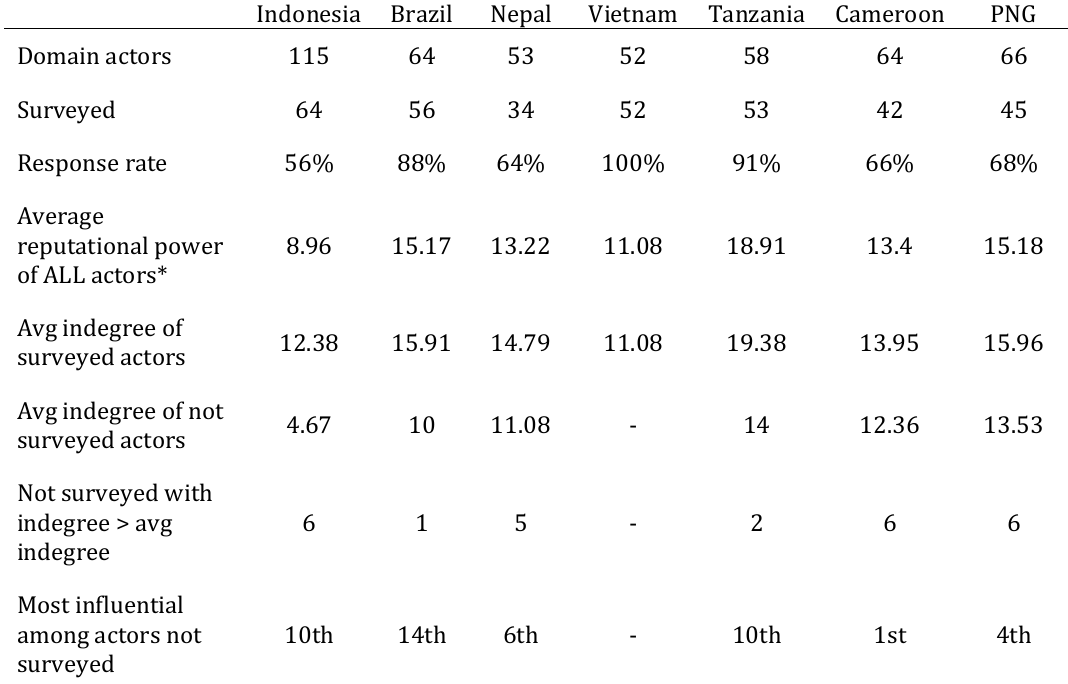
Table A1. Response rates of the social organization